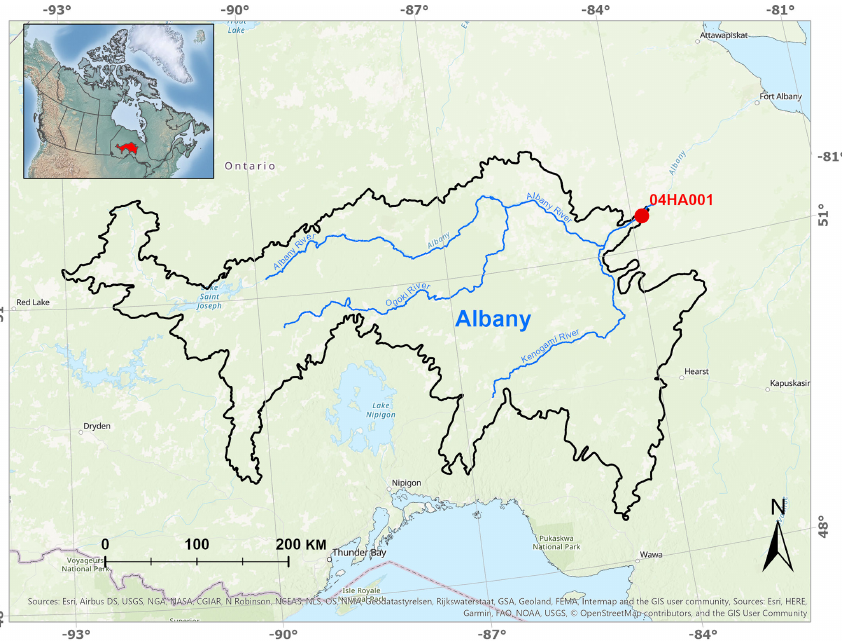
Figure 1. Location and geometry of the Albany River watershed and the gauge station. Study area in red is shown in the inset of Canada (© OpenStreetMap contributors 2020. Distributed under a Creative Commons BY-SA